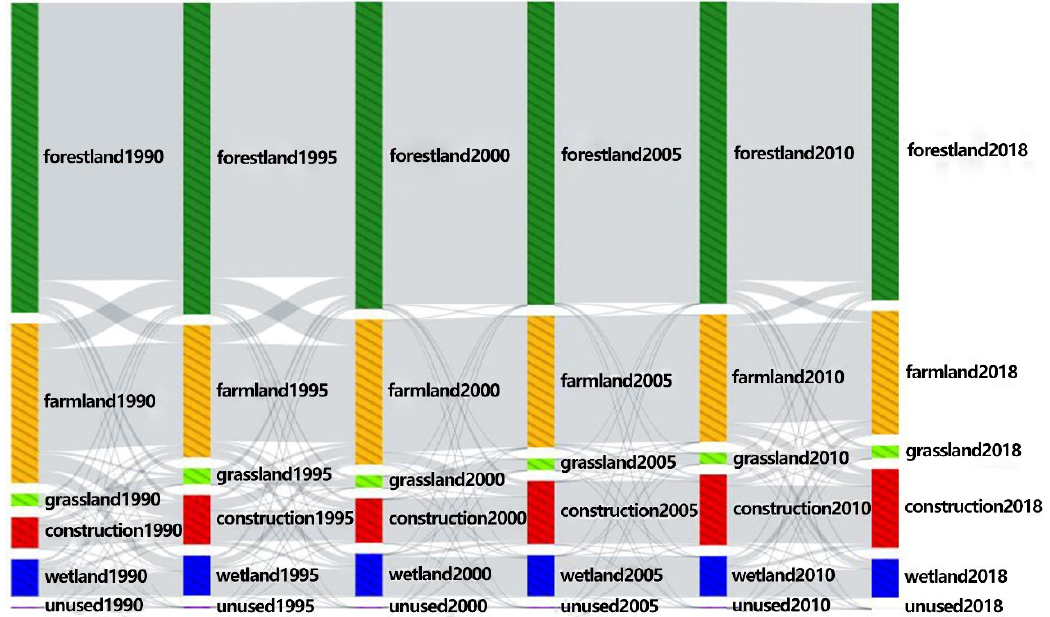
Figure 2. Sankey diagram of land-use change in the GBA.